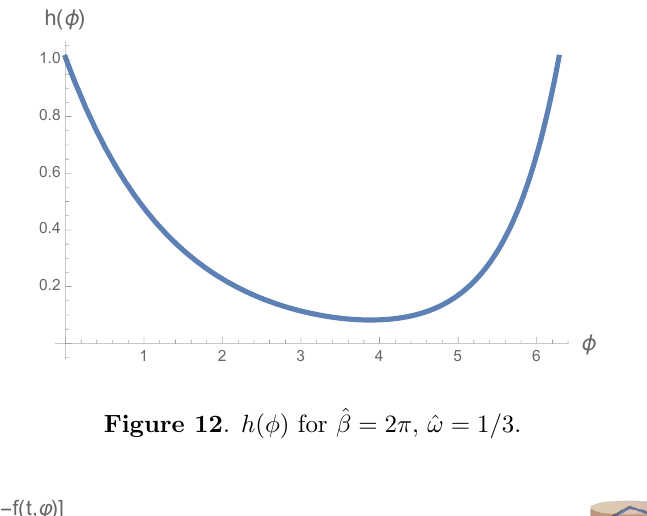
Figure 12 . h ( (cid:30) ) for ^ (cid:12) = 2 (cid:25); ^ ! = 1 = 3.